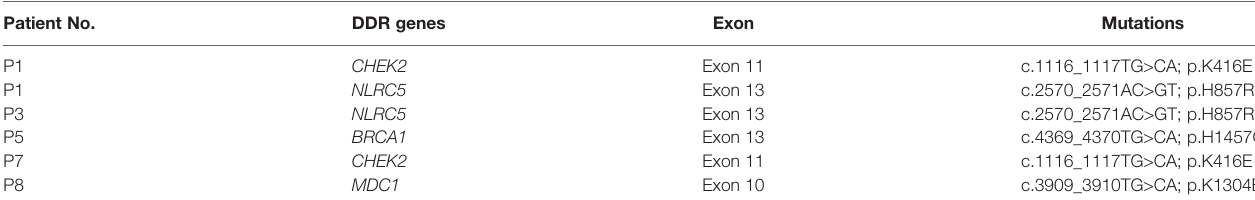
TABLE 2 | Single amino acid substitutions of DDR genes caused by continuous double base substitution. Patient No.